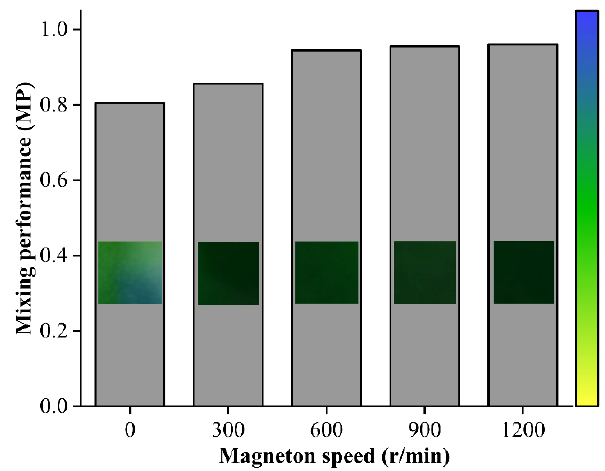
Figure 4. Mixing performance of different magneton